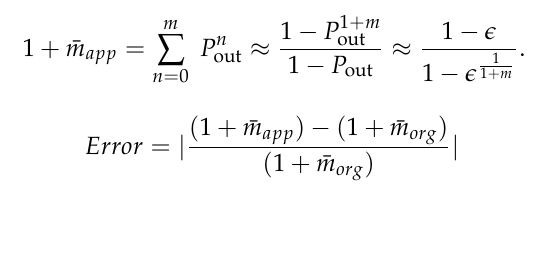
Figure 3. Comparison between the approximated and original average number of retransmissions 1 + ¯ m versus the outage threshold (cid:101) with different number of retransmissions. Moving on, we analyze the error between 1 + ¯ m app and 1 + ¯ m org